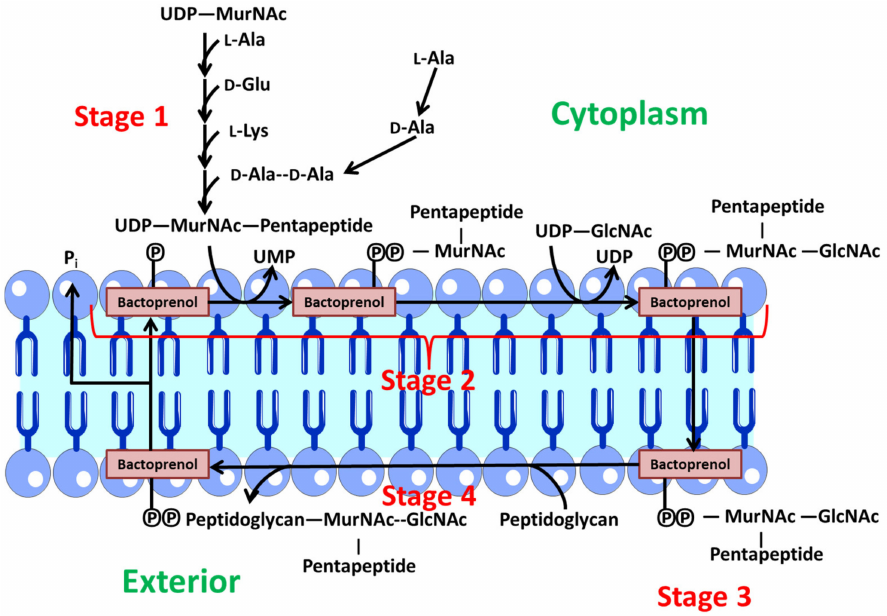
Figure 3. Peptidoglycans synthetic